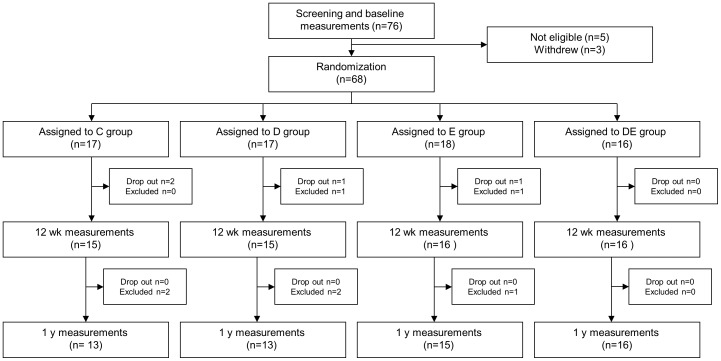
Subject-flow diagram of the LEVA trial.C denotes control, D dietary behavior modification, E exercise behavior modification, and DE combined dietary plus exercise behavior modification.